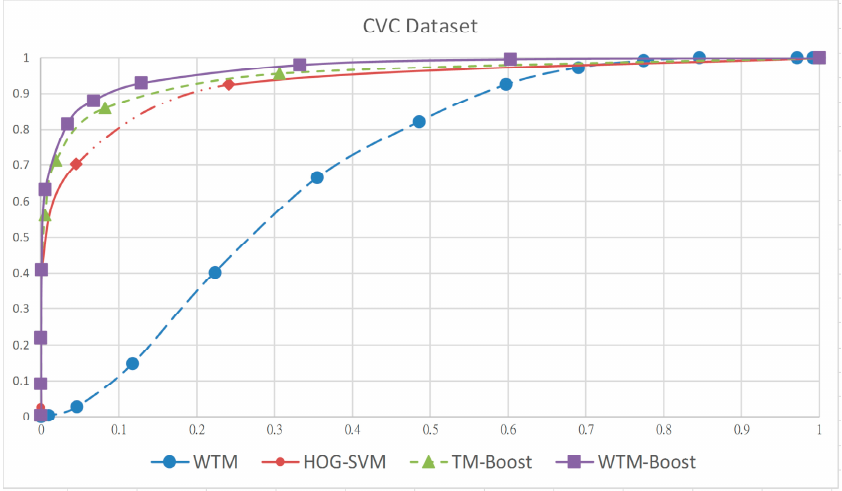
Figure 8. ROC curve for four approaches, WTM, HOG-SVM, TM-Boost, and WTM-Boost on CVC dataset.